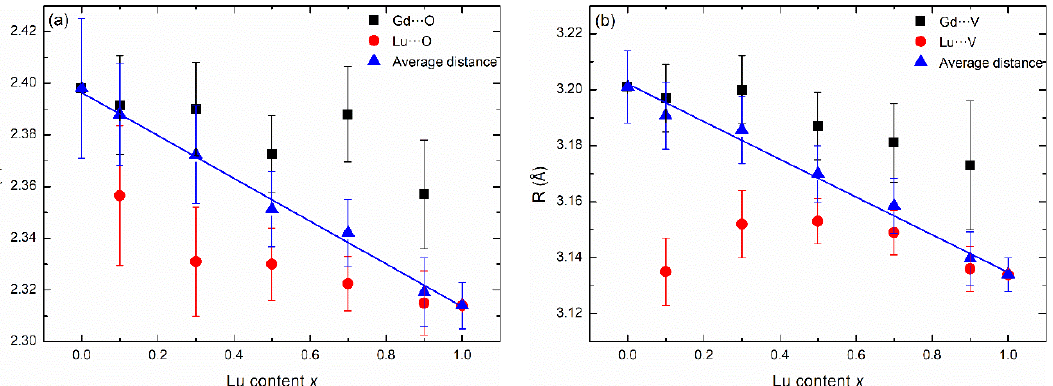
Figure 6. The ( a ) first and ( b ) second coordination shells’ interatomic distances with respective error bars of Gd 3+ (square) and Lu 3+ (dot), and the average distances (triangles) in the Lu x Gd 1 − x VO 4 solid solutions. The average distances are weighted values considering the elemental contents, and the solid blue lines are the linear fits.